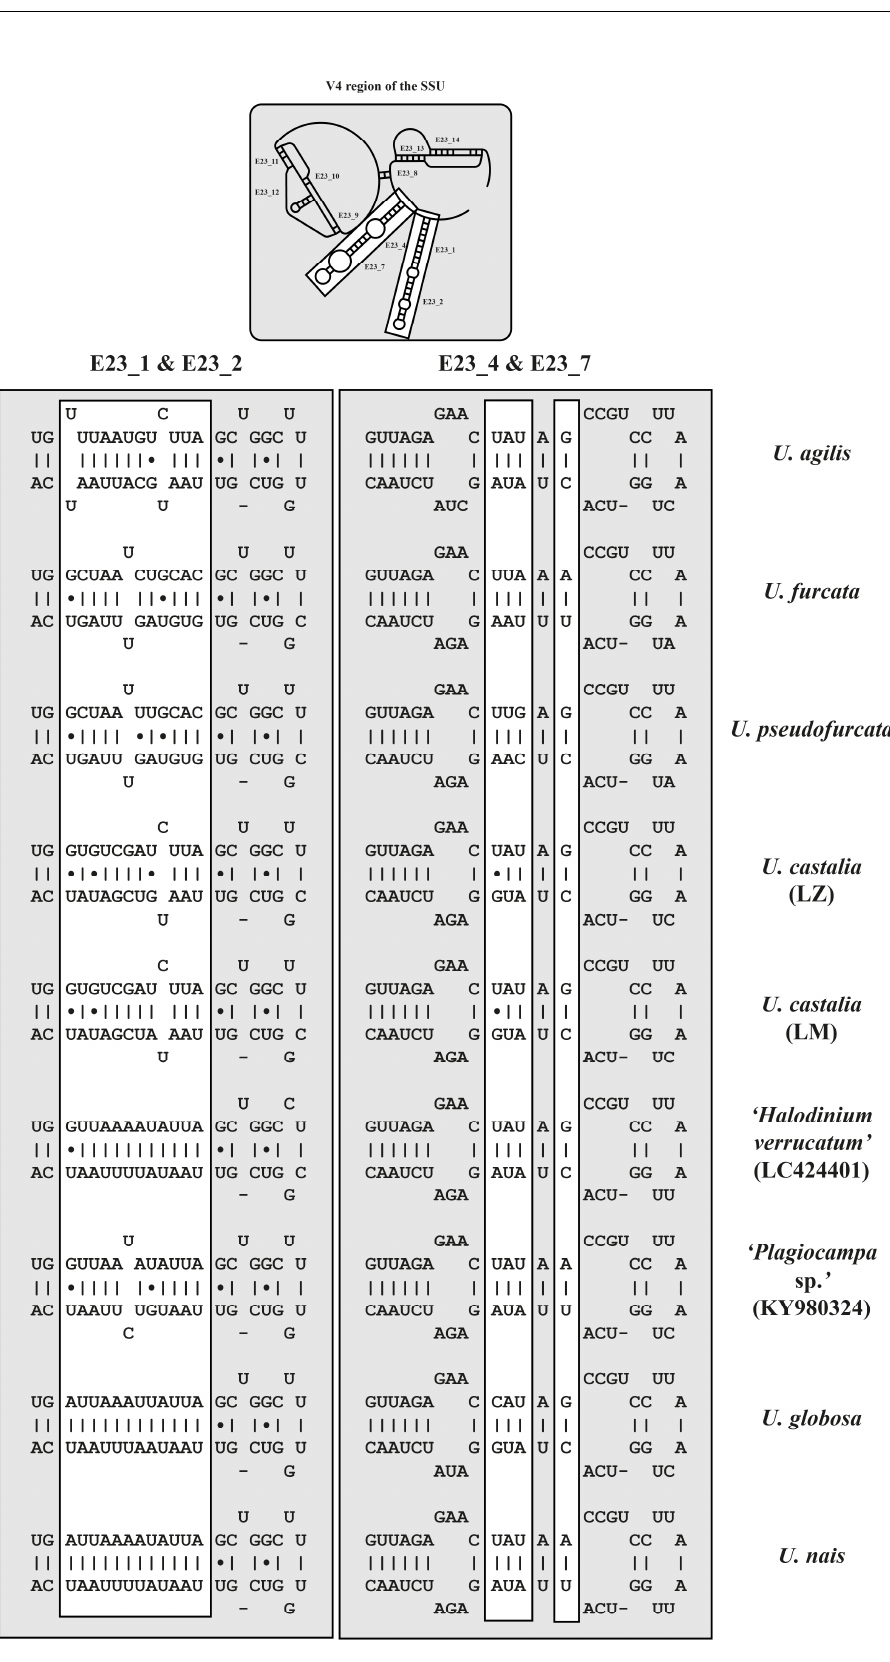
Figure 4. V4 secondary structures of the investigated Urotricha strains. The variable regions are marked by white boxes. The structures of E23_1/E23_2 and E23_4/E23_7 were calculated with mfold . The line graphic was drawn with PseudoViewer. LM, Lake Mondsee population; LZ, Lake Zurich population.